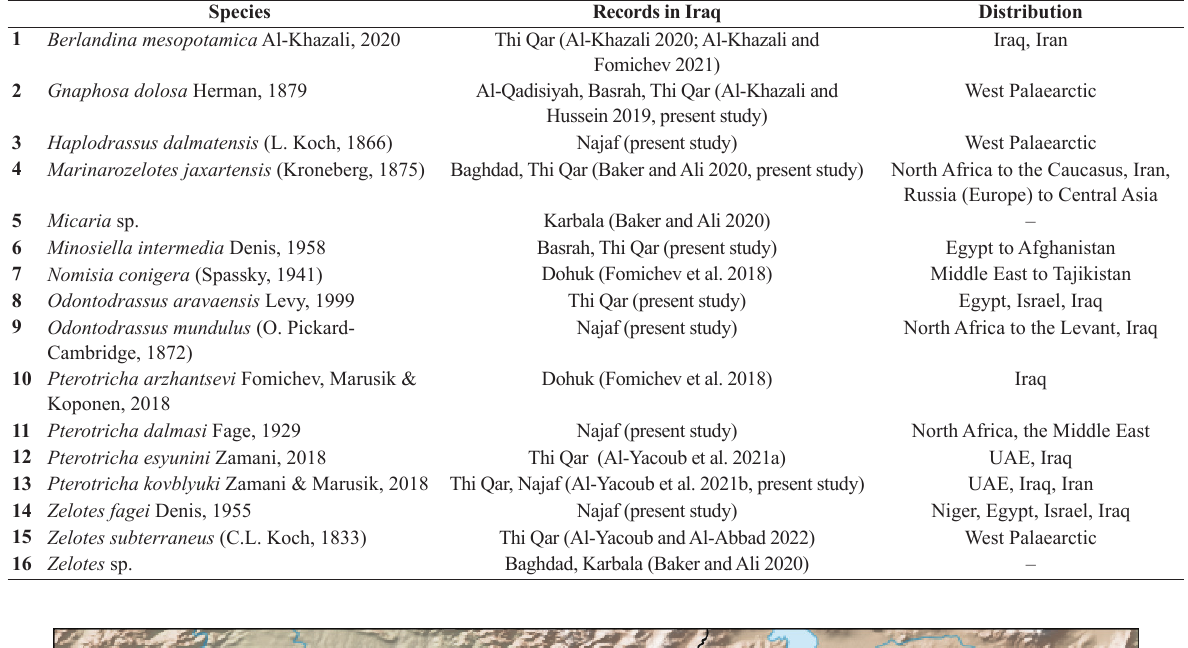
Table 1. List of gnaphosid species currently known from Iraq.